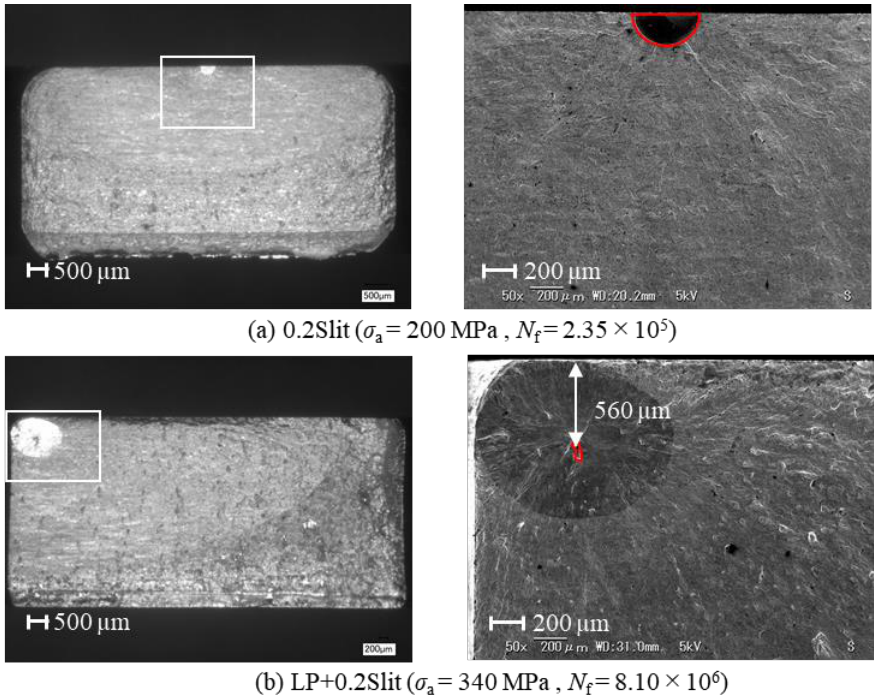
Figure 9. Fracture surface of the ( a ) 0.2 Slit and ( b ) LP + 0.2 Slit specimen.